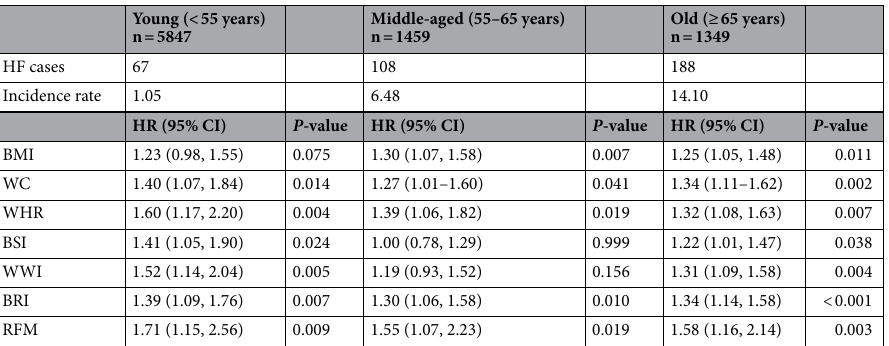
Table 3. Associations of adiposity indices with incident heart failure across age categories. Incidence rate is presented as HF cases per 1000-person years. Multivariable models were adjusted for age, sex, smoking, cholesterol, systolic blood pressure, glucose, and history of myocardial infarction, stroke and atrial fibrillation. Abbreviations same as in Table 2.